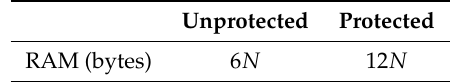
Table 2. Comparison of the Memory Usage between Unprotected and Protected